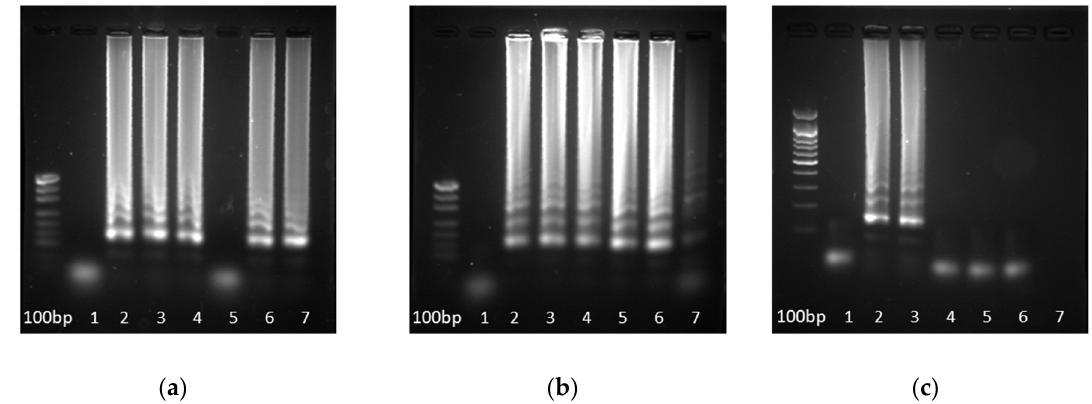
Figure 8. LAMP results for L. pneumophila , 2% agarose gel, targeting the dotA ( a ) and the lepB ( b , c ) gene; ( a , b ) DNA ladder 100 bp, line 1 = no template control, line 2 = serogroup (SG) 1, line 3 = SG 3, line 4 = SG 6, line 5 = SG 8, line 6 = SG 9, line 7 = SG 15; (c) dilution row. DNA ladder 100 bp, line 1 = no template control, line 2 = 500 pg µ L − 1 , line 3 = 0.5 pg µ L − 1 line 4 = 0.05 pg µ L − 1 , line 5 = 0.005 pg µ L − 1 , line 6 = 0.0005 pg µ L − 1 , line 7 = empty.